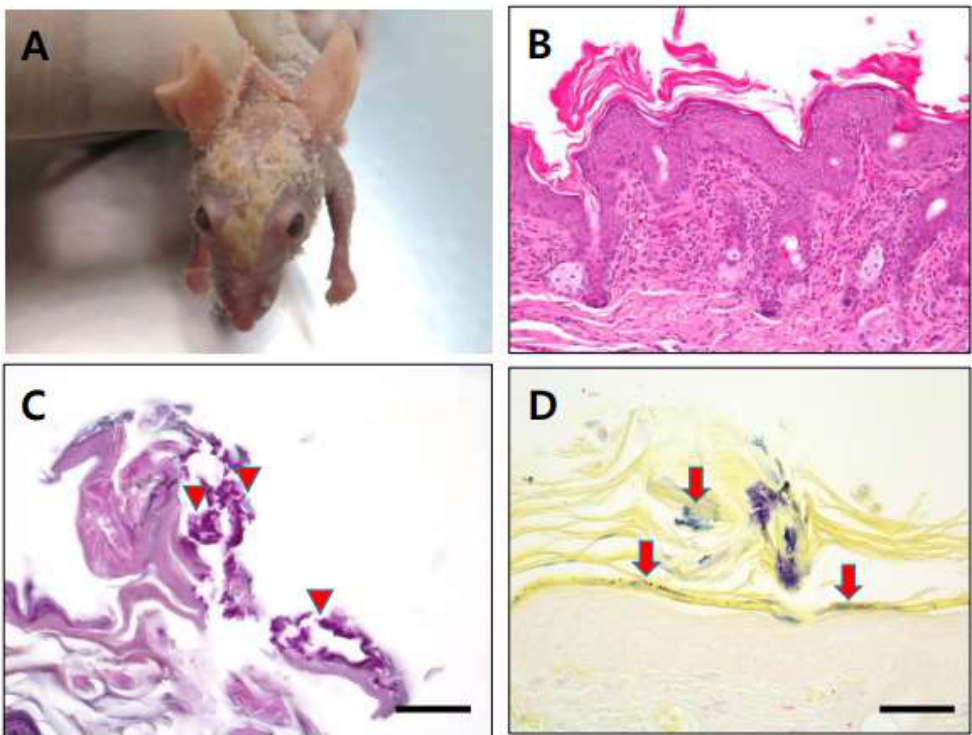
Figure 1. ( A ): Hyperkeratic skin lesion (cornmeal coating) was found in some C. bovis -infected im- munodeficient nude mice. ( B ): Section of skin lesion (hematoxylin and eosin stain), severe acanthosis, orthokeratotic hyperkeratosis, infiltrate of lymphocyte with plasma cell, and neutrophils within dermis. ( C ): Small rod and cocci shape were found in hyperkeratic region after PAS staining (arrow head). ( D ): Gram-positive rod shape bacteria located in hyperkeratic area (arrow). Scale bars = 50 μm.